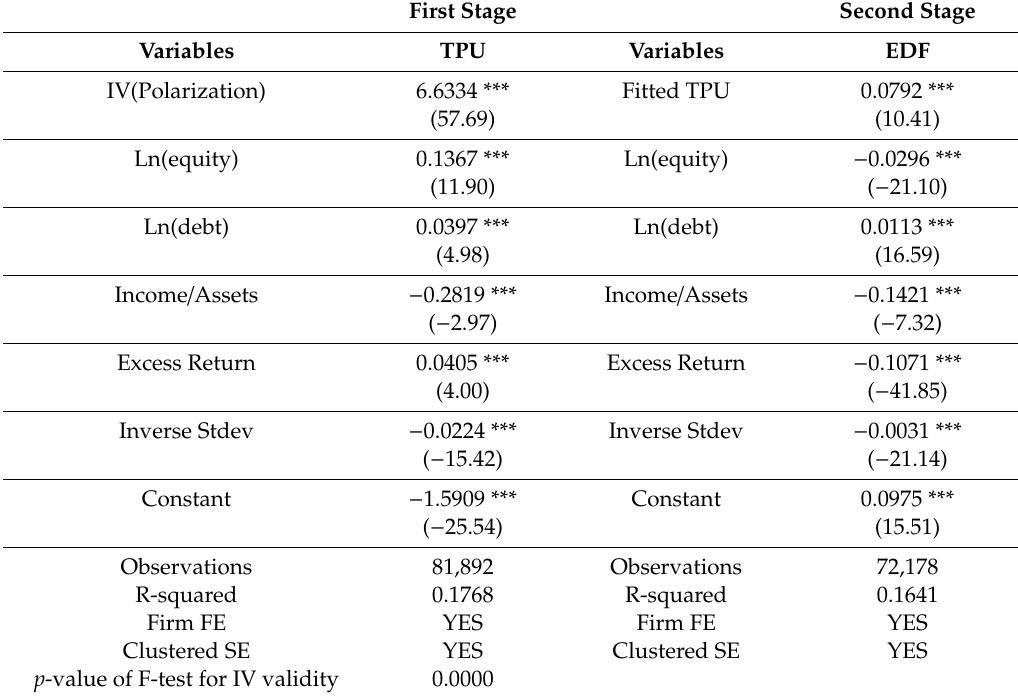
Table 7. Two-stage least square regression results for the relationship between tax policy uncertainty and the expected default frequency—this table presents two-stage least square regression results for the relationship between Tax Policy Uncertainty (TPU) and default risk. In the first stage, TPU is the dependent variable and Polarization is the instrumental variable. We define our instrument, Polarization , as the mean of DW-NOMINATE scores for the Republican party members in the Senate minus the mean for the Democratic party members in the Senate. The p -value of the F-statistic is reported for the validity test of the instrument. In the second stage, the regression model is the same as Table 1 panel A, except that fitted values of TPU from the first stage are used. All variables are defined in Appendix A. The T -statistics reported in parentheses are calculated using standard errors that are clustered at the firm level and are robust to heteroskedasticity. Symbols *** indicate statistical significance at 10%, 5%, and 1% levels,